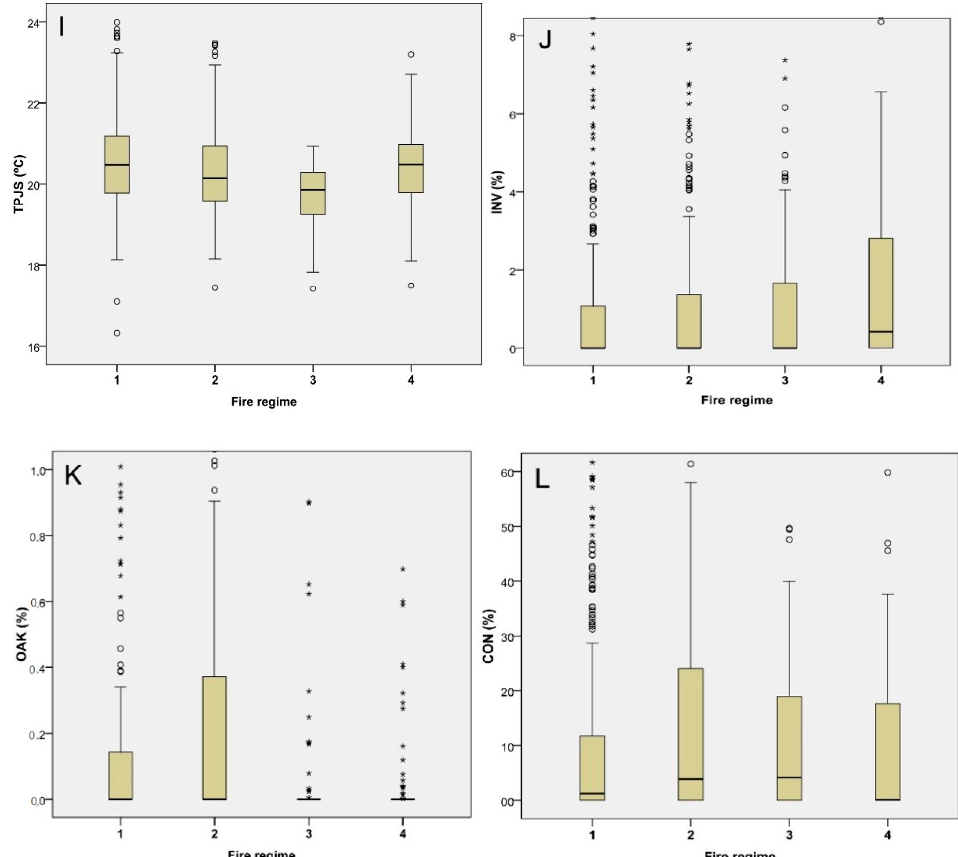
Figure 6. Boxplots for the values of each biophysical driver in each of the four fire regimes, by order of importance in the classification tree model. ( A ) SHR; ( B ) RFAJ; ( C ) SLO80; ( D ) AGR; ( E ) EUC; ( F ) BRD; ( G ) NPP; ( H ) FRAGF; ( I ) TPJS; ( J ) INV; ( K ) OAK; ( L ) CON. Circles identify potential outliers, defined as situated between 1.5X and 3X the interquartile range below the 1st quartile and above the 3rd quartile. Asterisks identify potential extreme outliers, exceeding three times the interquartile range below or above the 1st and the 3rd quartile. The boxplots are ordered by decreasing order of importance of the drivers in the classification tree model.